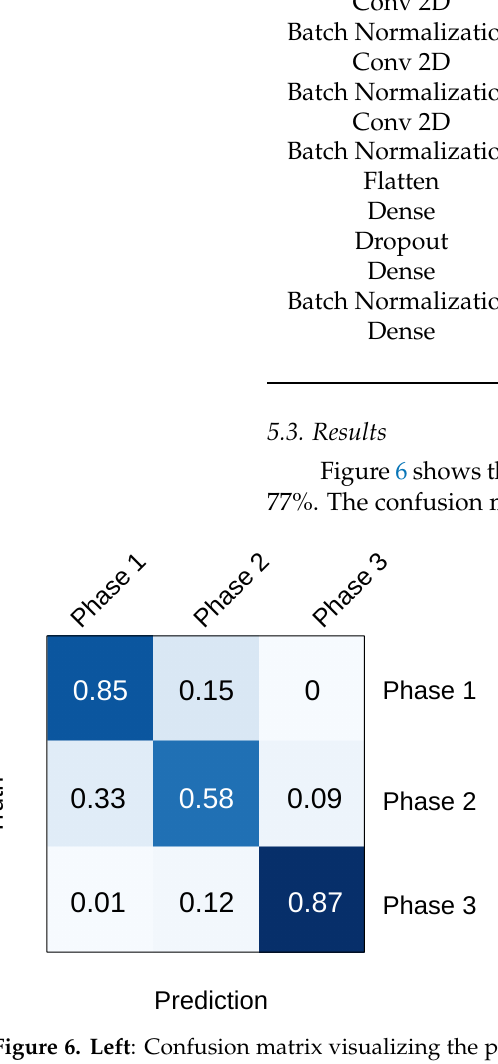
Figure 6. Left : Confusion matrix visualizing the performance of the classifier as the percentage of correct and incorrect classification of the damage phase (three phases of damage (Phase 1: Elastic deformation and microcrack initiation, Phase 2: pre-peak microcracking and Phase 3: Microcrack coalescence and post-peak crack localization)). Right : Overall training and validation accuracy of the classifier for 200